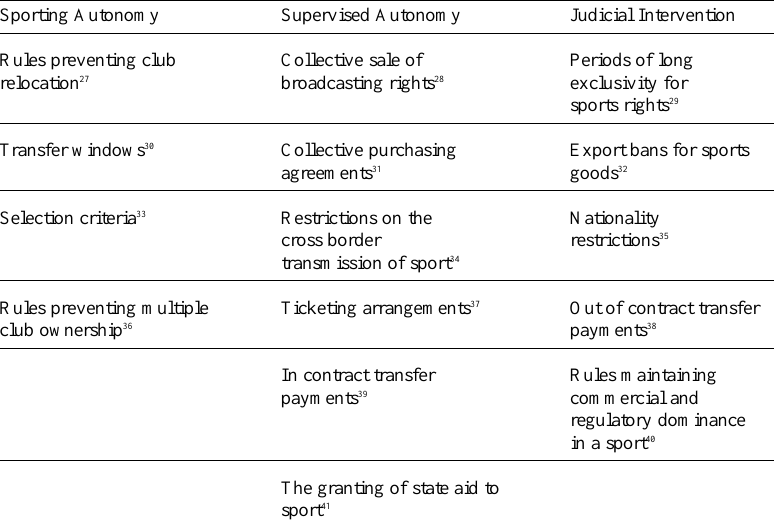
TABLE 2 THE SEPARATE TERRITORIES